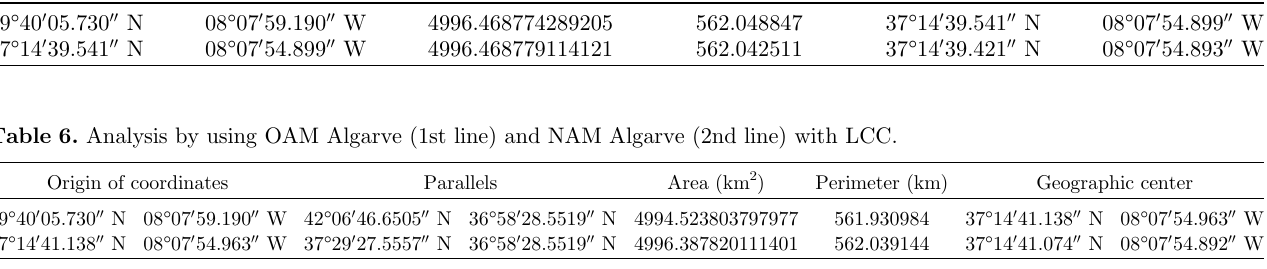
Table 5. Analysis by using OAM Algarve (1st line) and NAM Algarve (2nd line) with LAEA. Origin of coordinates Area (km 2 ) Perimeter (km) Geographic